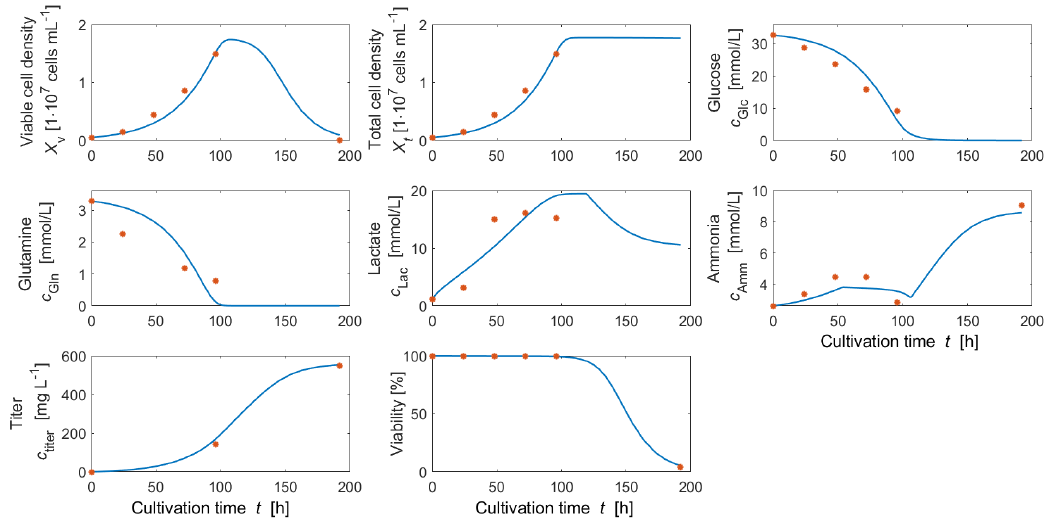
Figure 4. Measurements (red dots) and simulated time profiles (blue solid lines) of viable and total cell density, glucose concentration, glutamine concentration, lactate concentration, ammonia concentration, volumetric titer and viability after Bayesian parameter estimation (based on the maximum a posteriori estimate (MAP)) at 500mL scale (TubeSpin bioreactor 600 TM ).